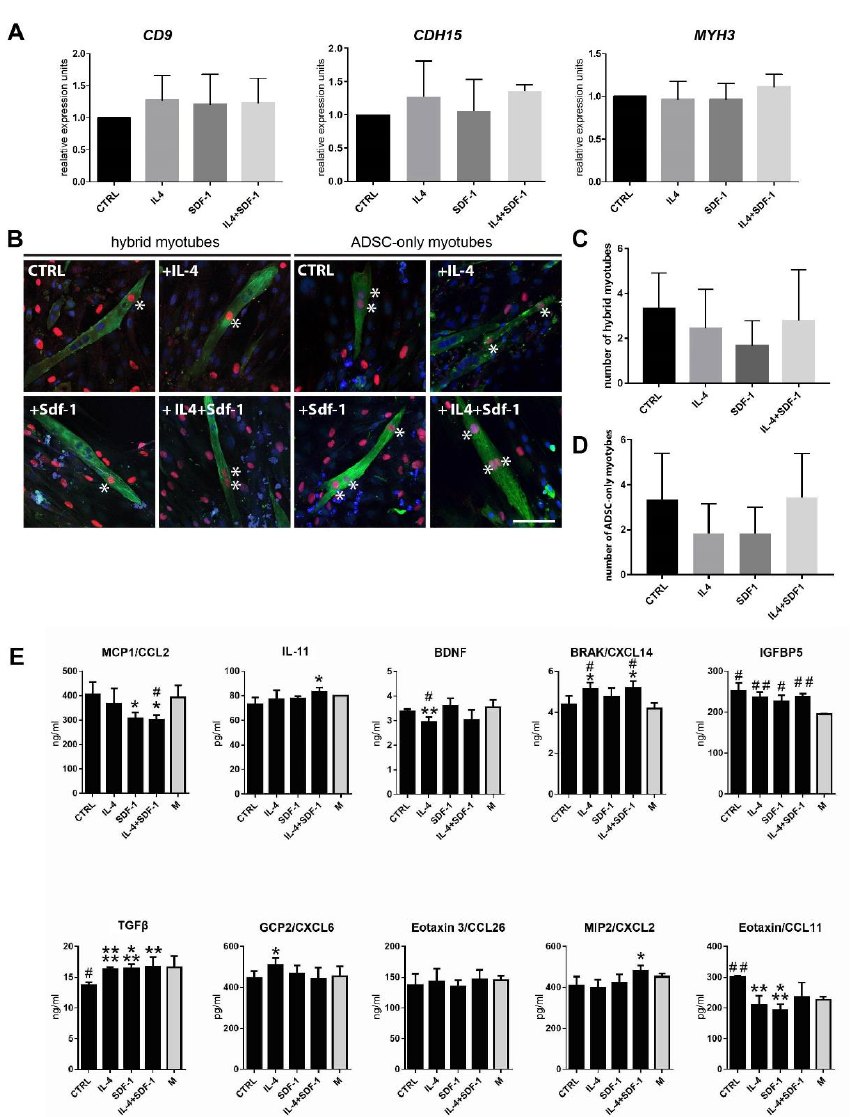
Figure 7. Characterization of hADSCs cultured under control conditions or in the presence of IL-4, SDF-1, or IL-4 and SDF-1. ( A ) Analysis of the level of mRNAs encoding CD9, M-cadherin (Cdh15), and MyH3. Expression was related to the levels observed in control cells and normalized to mRNA encoding ACTB. ( B ) Analysis of co-culture of hADSCs with mouse C2C12 myoblasts using immunolocalization of human nuclei (red), all nuclei (blue), and skeletal myosin (green), bar = 50 µm. ( C ) Number of myotubes formed in the co-culture between hADSCs and mouse C2C12 myoblasts. ( D ) Number of myotubes formed from hADSCs only. ( E ) Level of MCP1/CCL2, IL-11, BDNF, BRAK/CXCL14, IGFBP5, TGFβ, GCP2/CXCL6, Eotaxin 3/CCL26, MIP2/CXCL2, and Eotaxin/CCL11 was assayed using ELISA in medium in which hADSCs were cultured. For each experimental group n ≥ 3. Data are presented as mean ± SD. Data has been analyzed using Student’s t-test ( E ) or Kruskal-Wallis test ( A,C,D ). * p < 0.05; ** p < 0.01, *** p < 0.001, **** p < 0.0001, # p < 0.05, ## p < 0.01, ### p < 0.001, #### p < 0.0001. Asterisks depict the differences between the experimental samples and control samples; hashtags depict results related to the level in medium (M).